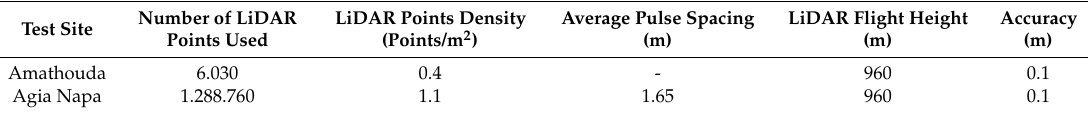
Table 2. LiDAR data specifications.